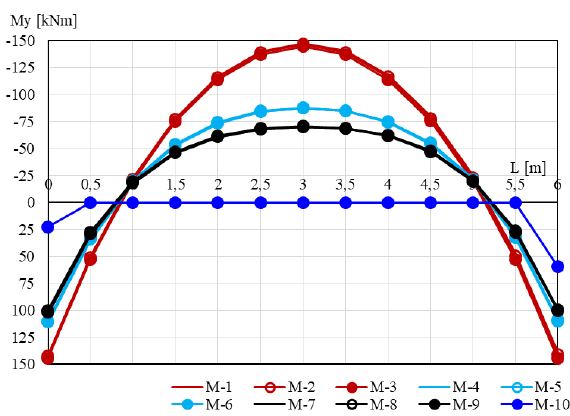
Figure 11: Distribution of bending moments in bridge’s bottom slab.